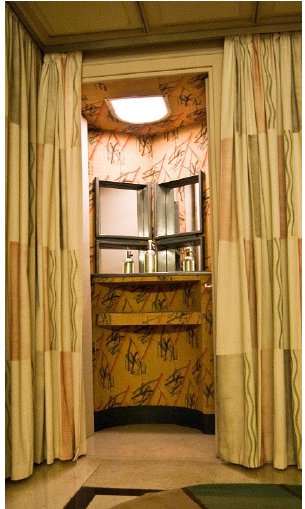
Figure 12. Molle apartment, bar area with textiles decorate by Fides Testi (the covering in raw hemp was designed by Vittorio Morpurgo), about 1932. © Archivi delle arti applicate italiane del XX secolo, Rome. Used by permission.